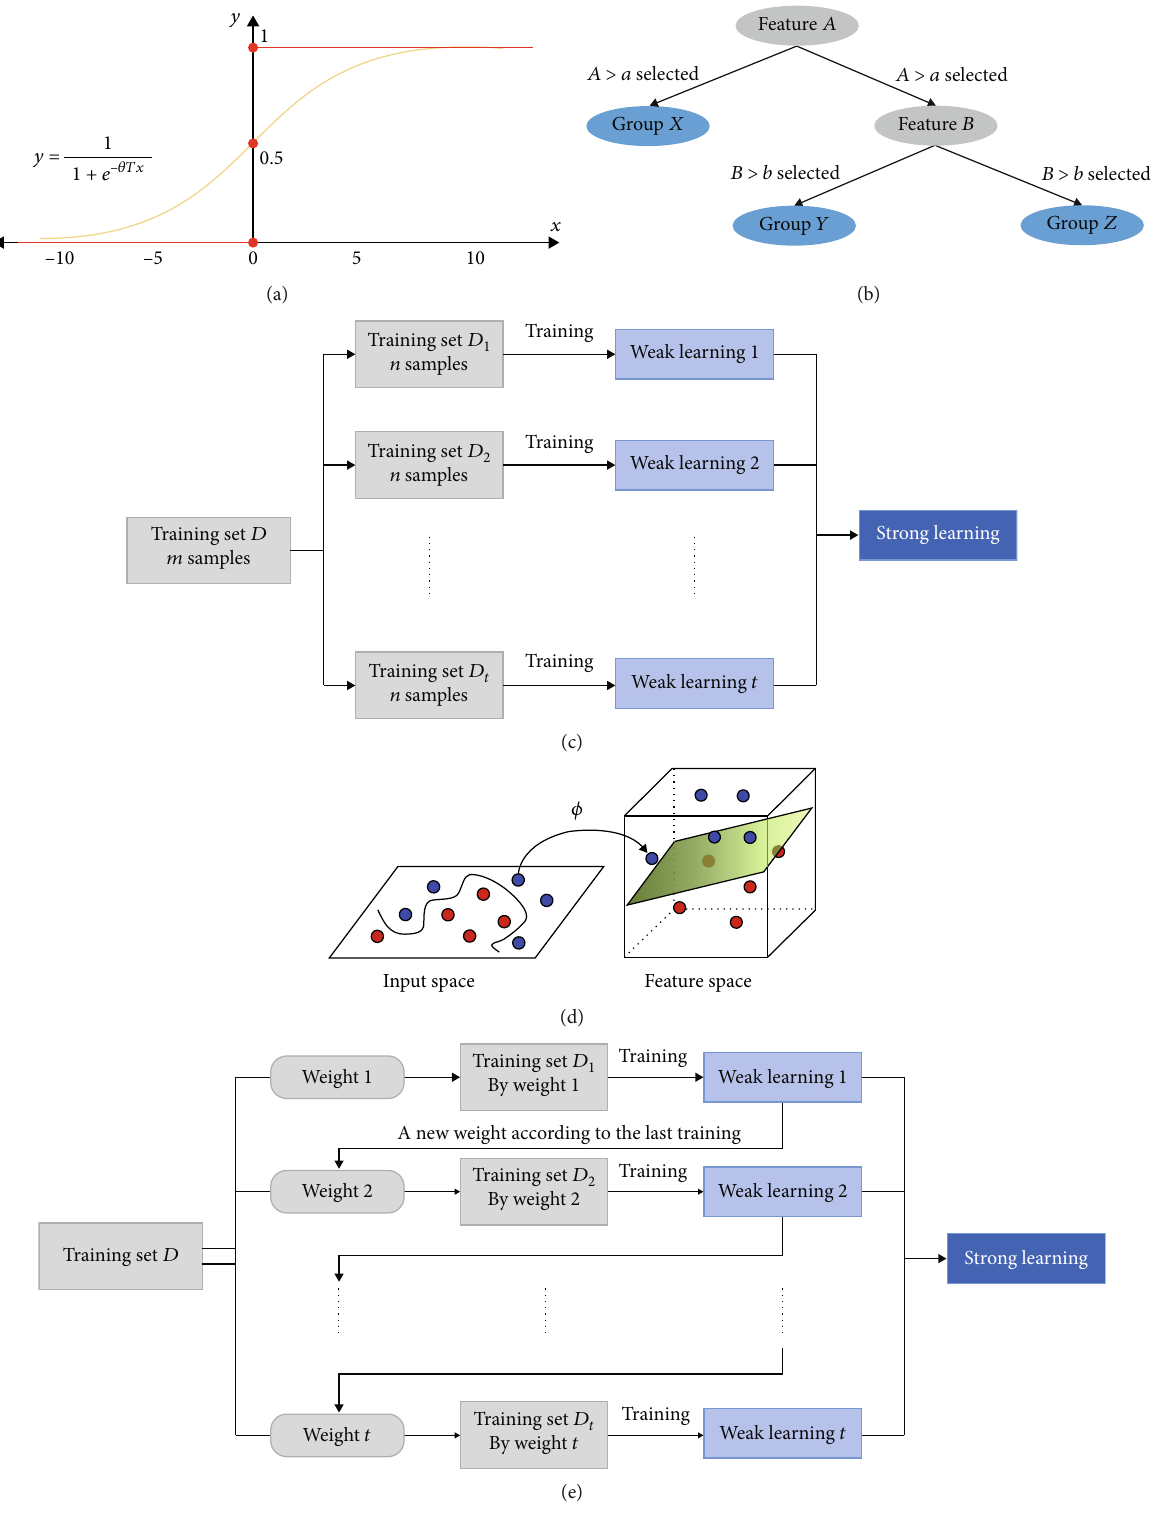
Figure 1: The graphic expression of di ff erent machine learning algorithms: (a) logistic regression, (b) classi fi cation and regression tree, (c) random forest, (d) support vector machine, and (e) extreme gradient